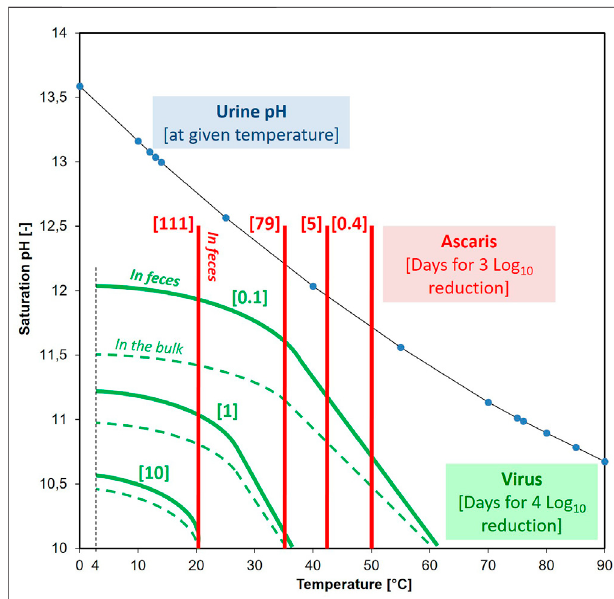
FIGURE3| Calculatednumberofdaysrequiredfora3log 10 reductionin Ascaris [red] atthegiventemperature(pHdidnotimpacttheinactivationrate). Calculated number of days for a 4 log 10 reduction in virus [green] at the given temperature and pH. Solid green line is for virus enmeshed in fecal material and the dotted line is for virus without enmeshment. As the temperature changes, so does the pH of urine/Ca(OH)2 solution (indicated by the blue